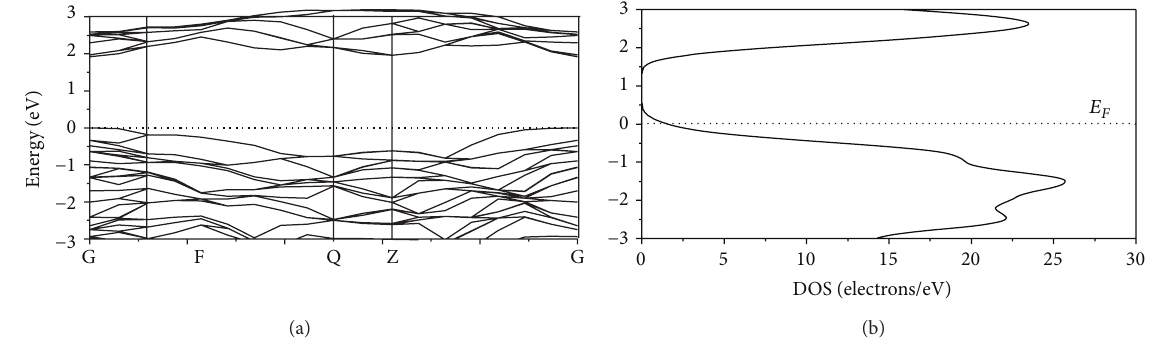
Figure 2: (a) The band structure of rutile TiO 2 . (b) The total density of rutile TiO 2 .